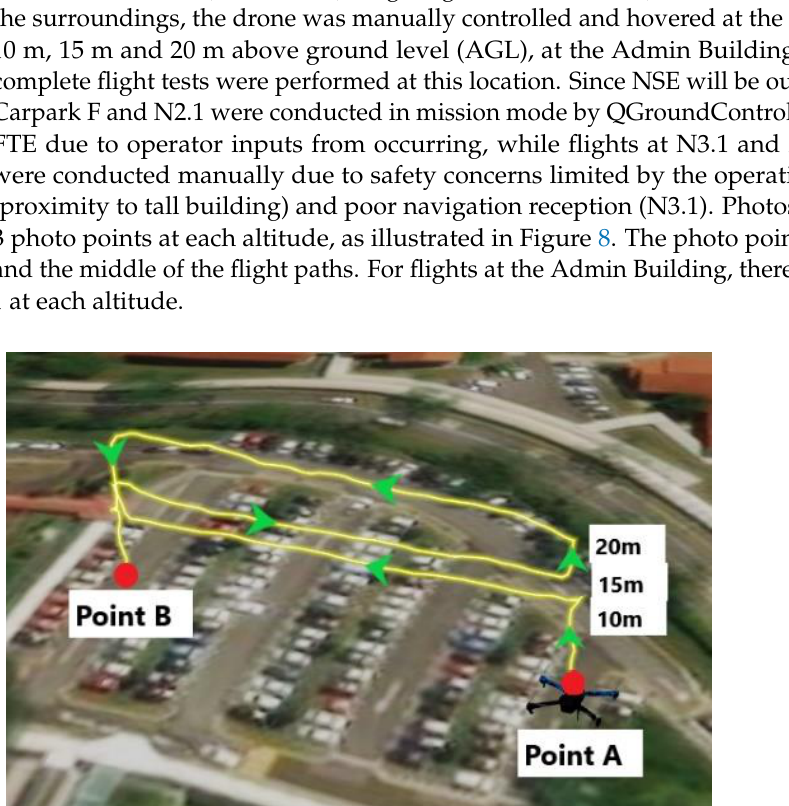
Figure 8. Illustration of Different Points at Three Altitudes for the N3.1 Location. The data collected will be analysed with considerations for: i. No. of visible satellites vs. flight altitude. ii. Horizontal position errors by comparing reported position and actual position (NSE). iii. Sky openness ratio vs. horizontal position accuracy.